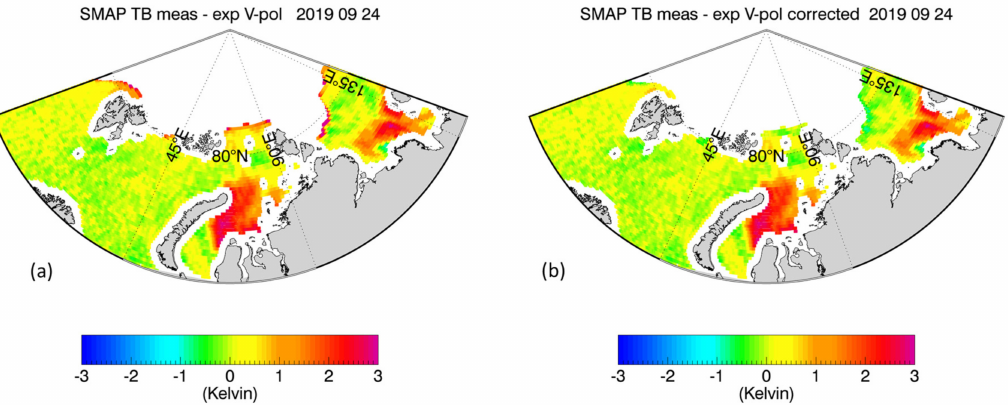
Figure 10. SMAP V-pol TB biases for an Arctic test scene on 24 September 2019 (Set 8 from Table 1). ( a ) before flagging and correction in zones 0–3; ( b ) after flagging and correction showing zones 0–2. The large red areas indicate freshwater river outflows. These areas are not affected by the sea-ice flagging and correction